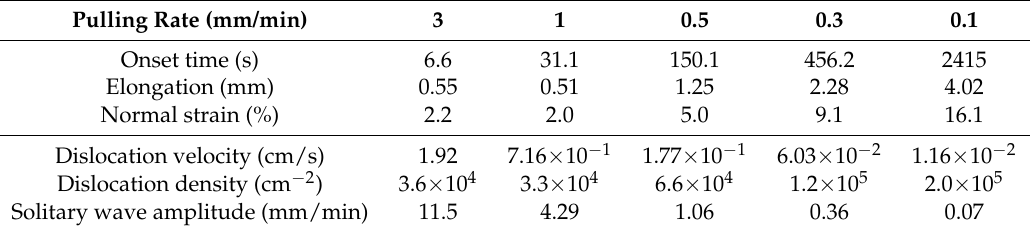
Table 2. Various quantities at onset of shear band propagation. Quantities in the top three rows are found directly from experimental data. Quantities in the bottom three rows are evaluated based on